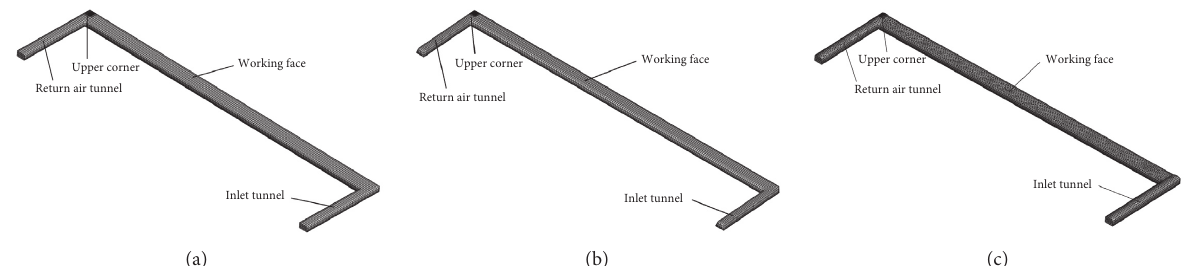
Figure 10: Physical models of different cross-sectional shapes: (a) rectangular section; (b) trapezoidal section; (c) semicircular arch section.